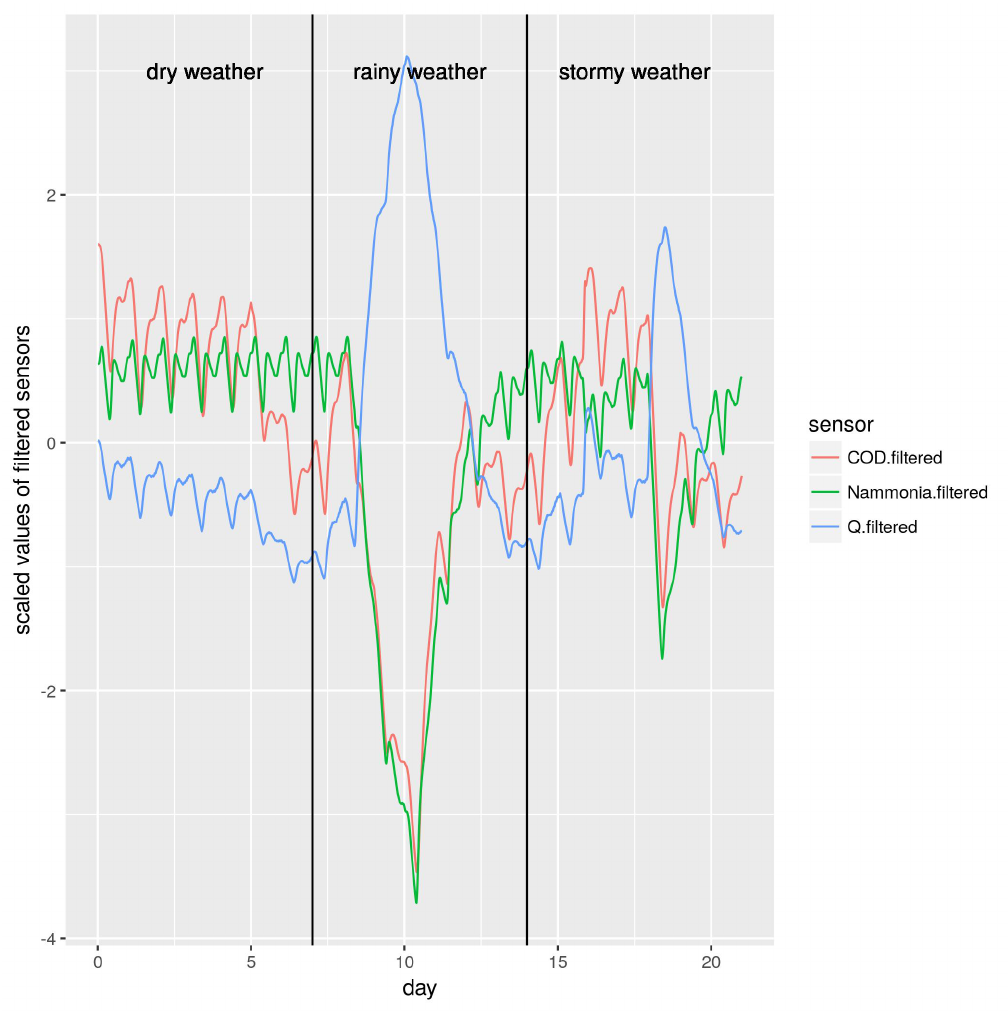
Figure 3. Relationships among Q, COD and N-ammonia measures after being scaled and